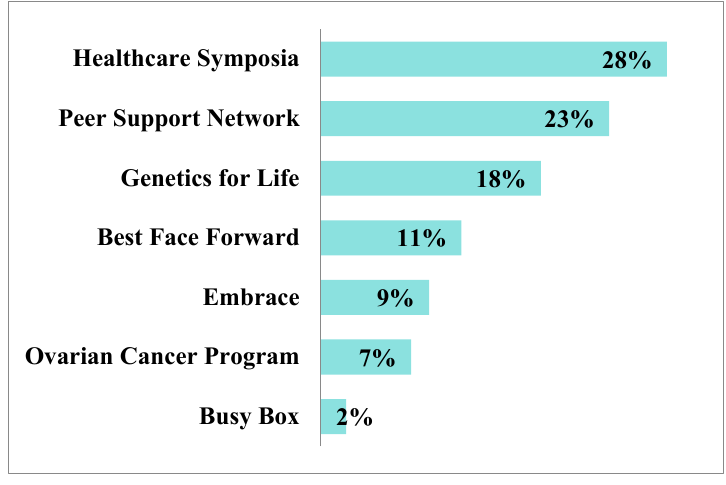
Figure 1. Future Information and Support